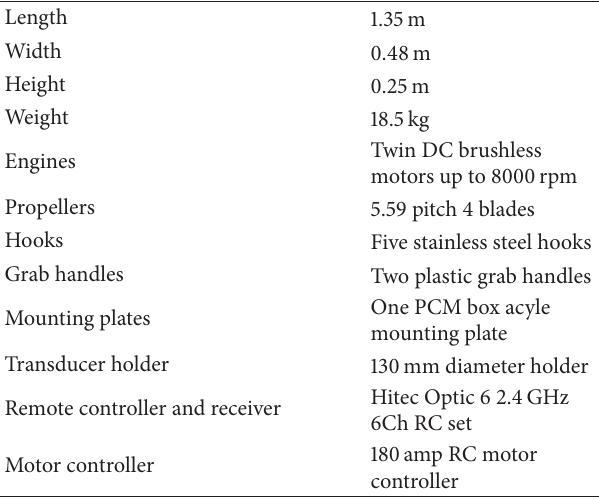
Table 1: Specification of remote-controlled